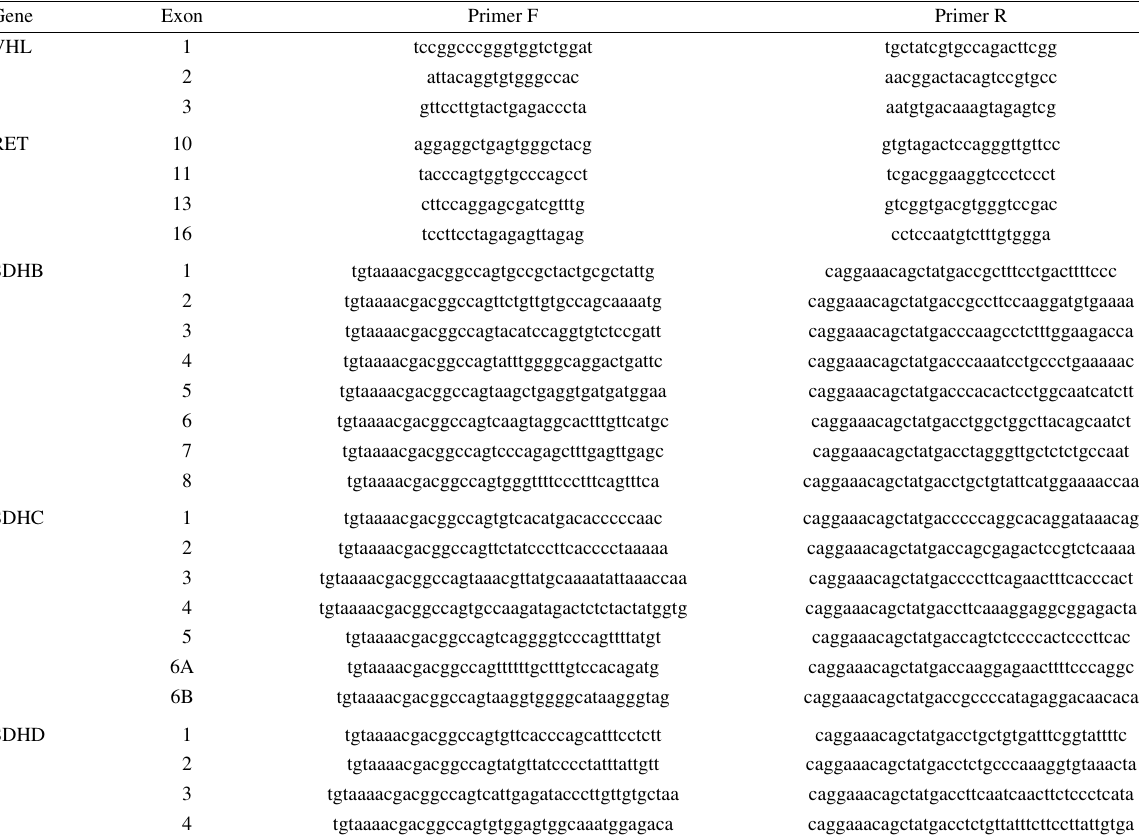
PCR primers used in the mutational